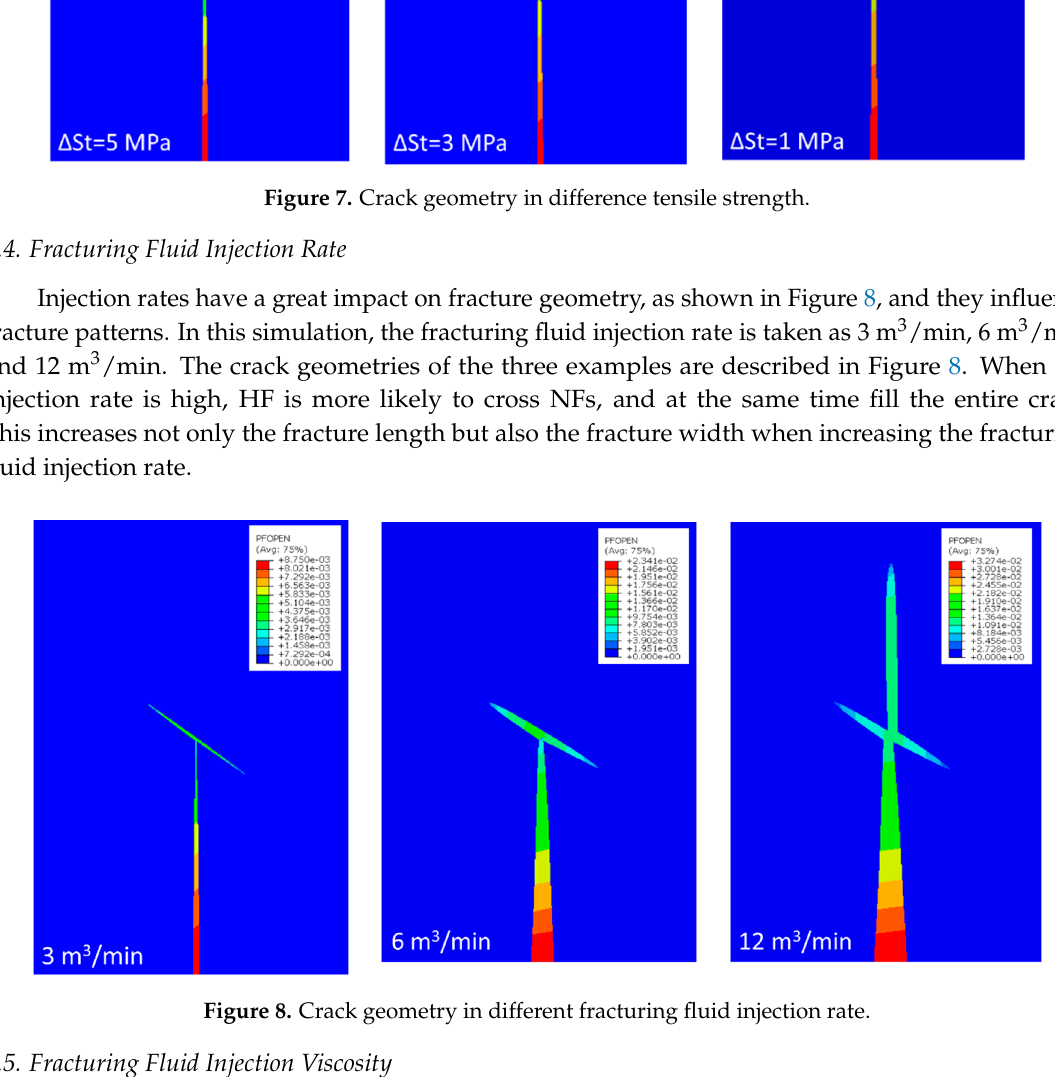
Figure 9. Crack geometry in different fracturing fluid injection viscosity. 5. Conclusions In this paper, we developed a fully coupled poro-viscoelastic fracture propagation model to investigate the characteristics of hydraulic fracturing in shale formation. The numerical simulation adopted is the finite-element method and detailed implementation steps are presented. Simulations of poro-viscoelastic fracture propagation confirm the generally accepted notion that creep behavior has a detrimental effect on hydraulic fracturing efficiency. From the analysis, it is found that fractures propagating in poro-viscoelastic formation tend to be wider yet shorter than that in poro-elastic formation, which is mainly due to viscous energy dissipation. By using a cohesive finite-element model, different factors that effect HF interacting with NF have been investigated and clearly simulated. On the one hand, the interaction between HF and NF can promote the expansion of flow paths; on the other hand, it may lead to an extra leak-off. Using